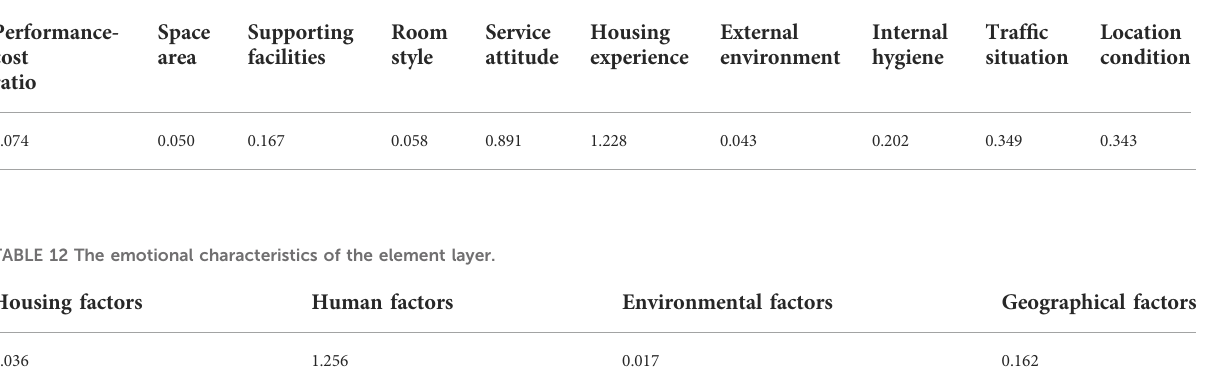
TABLE 11 The emotional characteristics of the index layer.